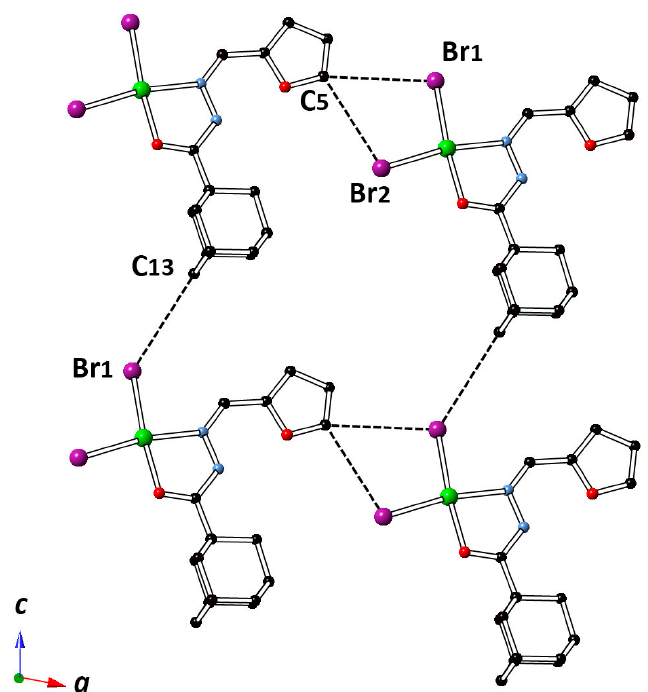
Figure 3. Crystal packing of 1 in the ac-plane, dashed lines is the shortest weak interactions in 1 .